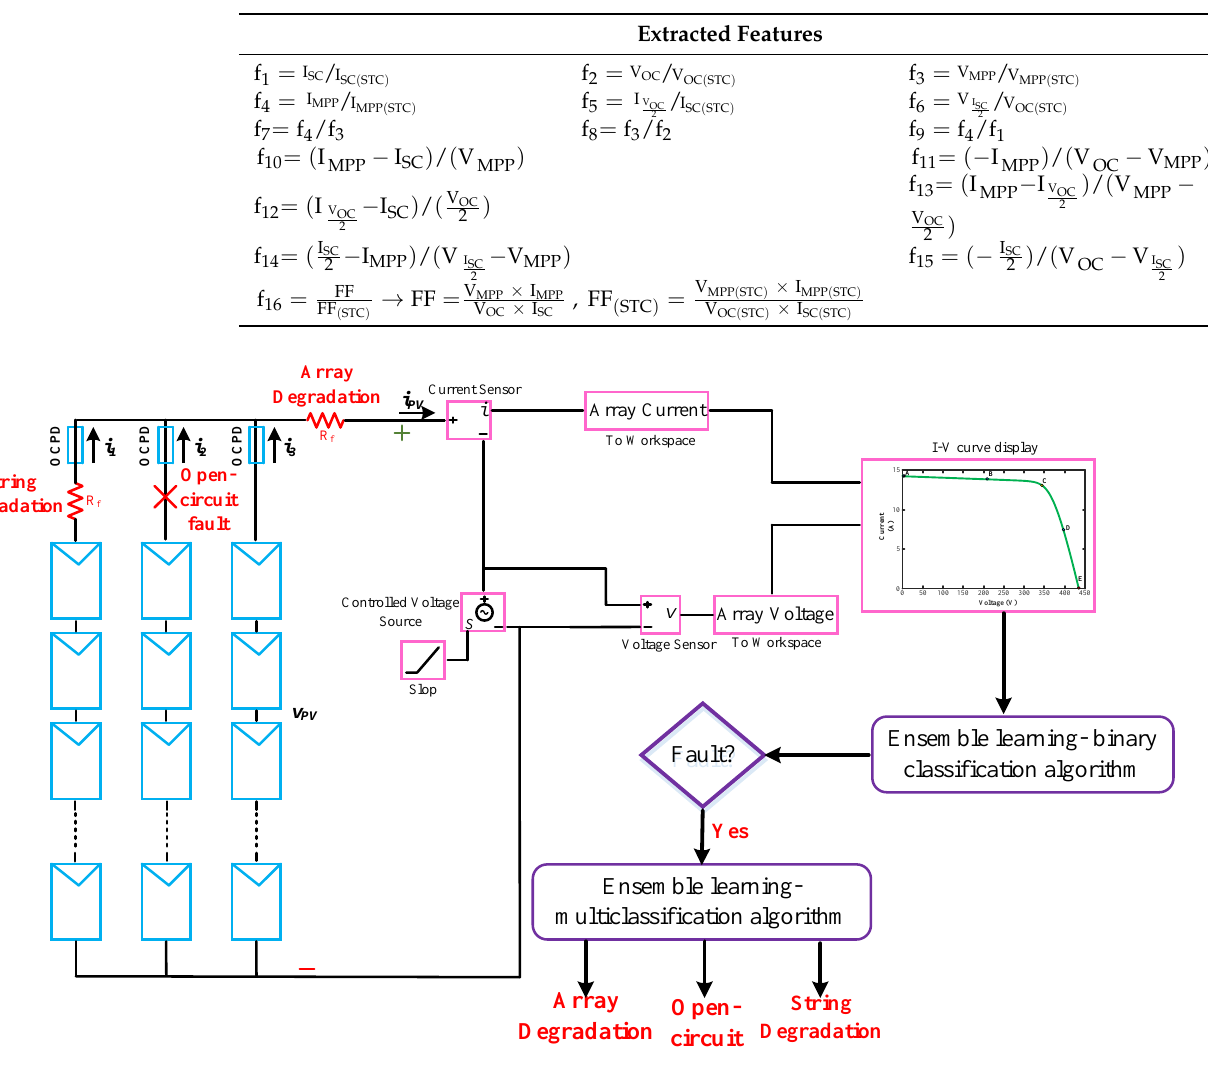
Figure 11. Overall view of the proposed EN model for fault diagnosis.